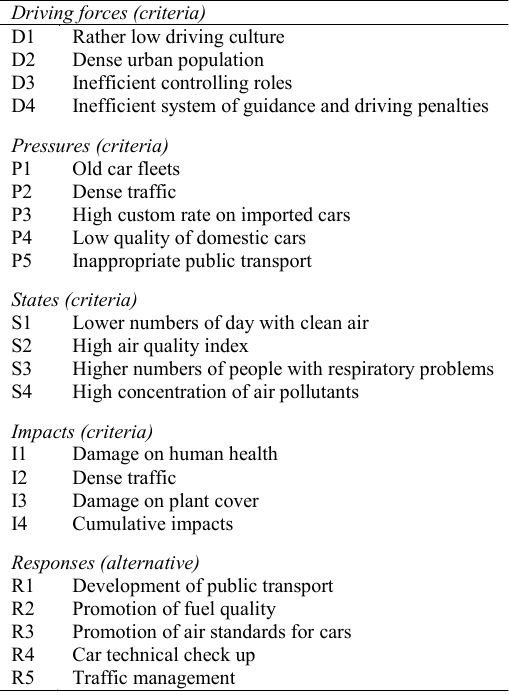
Table 1: DPSIR factors in Tehran metropolitan Driving forces (criteria) D1 Rather low driving culture D2 Dense urban population D3 Inefficient controlling roles D4 Inefficient system of guidance and driving penalties